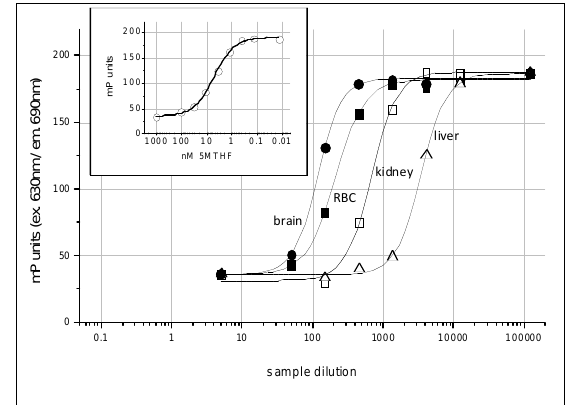
Figure 3. FP assay of folate in human erythrocytes (RBC) and Swiss mouse tissues. Mouse liver ( D ), kid- • ney ( ¤ ), brain ( ) and human erythrocytes ( n ) were tested for their ability to inhibit Alexa 660-folate bind- ing to FBP. A standard curve (inset) of inhibition of FBP by known quantities of 5-methyl THF was also o ) generated (